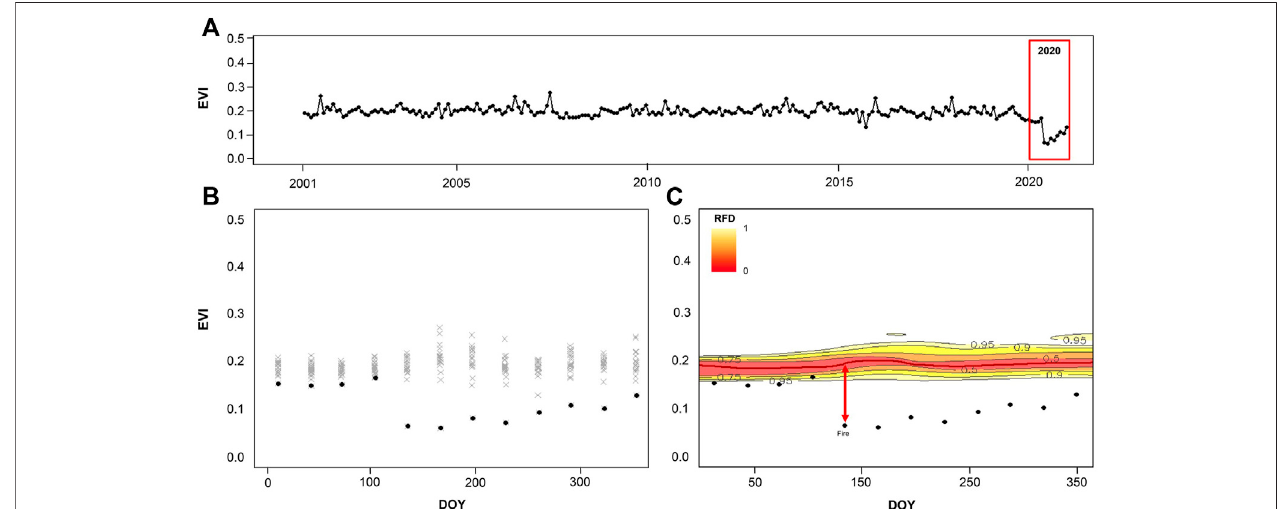
FIGURE 2 | The probabilistic “ npphen ” approach used to detect and quantify precursory extreme environmental conditions of a fi re event, in this example, the canopy status given by the Enhanced Vegetation Index (EVI). (A) A time series of a variable of interest, in this example monthly EVI values, is used as input; (B) the multi- year EVI time series is arranged in a scatterplot with the X axis de fi ned as the day of the year (DOY), i.e., 365 days, and the Y axis de fi ned as the EVI dynamic range, i.e.,0 – 1;andin (C) akerneldensityestimationoftheEVI-DOYspaceiscalculated(coloredareas)wherethereddishareashighlightthemostexpectedEVIalongthe year. From this kernel, the most expected EVI value along the year is de fi ned (dark red line), EVI anomalies are calculated (red arrow) per date and to the position of the observations within the reference frequency distribution (RFD) is obtained, which is an indicator of how extreme the anomaly is (in this study RFD > 0.95 are considered